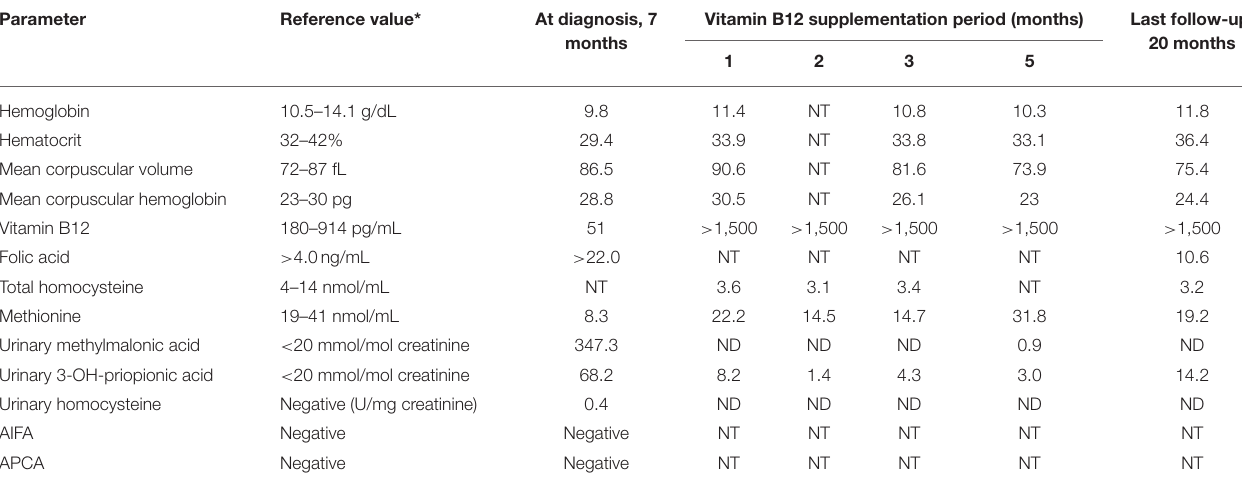
TABLE 1 | Admission and follow-up biochemical parameters of the patient.